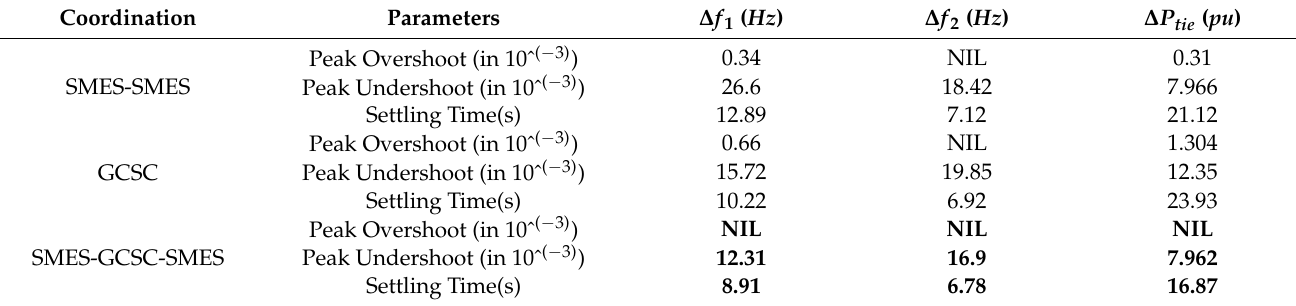
Table 14. Numerical values of T s ( s ), M P , and U P for AGC. Coordination